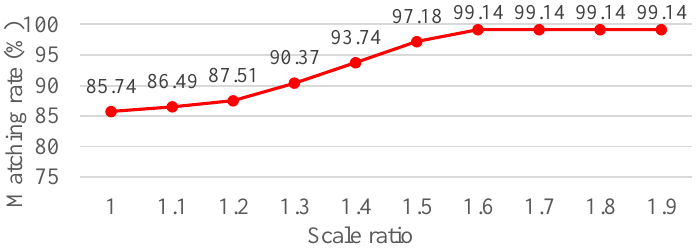
3 of 23 Figure 1. A flow chart indicates the template image and testing image are both utilized the proposed FBRLF method to compare the similarity. The procedure of the proposed FBRLF method is shown as the red box. 2.1. Scale-Space Feature Detection The accelerated segment test (FAST) [29] is a famous corner feature point detection, and the adaptive and generic corner detection based on the accelerated segment test (AGAST) [30] can significantly improve the FAST algorithm on its performance. Yet, feature points acquired through the FAST and AGAST are not scale-invariant. Consequently, this study proposes the multiscale AGAST (MAGAST) detector, which adopts a two-octave image-capturing technique to maintain scale-space invariance and proposes adaptive optimum threshold value based on AGAST which underlies the FAST. Specifically, this technique involves sampling an image twice, and prevents extensive calculation. Thus, it can achieve multiscale invariance, and increase the overall system efficiency. First, a set of captured images is processed for each octave. The first-octave and second- octave image sets are denoted as {𝐿 0 , 𝐿 1 , 𝐿 2 , … 𝐿 𝑛−1 } and {𝑀 0 , 𝑀 1 , 𝑀 2 , … 𝑀 𝑛−2 } , respectively. The process for building a two-octave image pyramid is described as follows. (1) If 𝐿 0 is the original image undergone smoothing once, then 𝐿 1 is generated by decimating 𝐿 0 by 1/2, 𝐿 2 is generated by decimating 𝐿 1 by 1/2, and so on. These images form the first-octave image set. (2) The second-octave image set is established on the basis of the first-octave image set. Specifically, M 0 is generated by decimating 𝐿 0 by 2/N, where N is the number of images per octave. M 1 is generated by decimating 𝑀 0 by 1/2, M 2 is generated by decimating 𝑀 1 by 1/2, and so on. In Eqs. (1) and (2), 𝑆(𝐿 𝑖 ) and 𝑆(𝑀 𝑖 ) represent the scale relationships of the first-octave image L i and second-octave image M i , respectively. 𝑆(𝐿 𝑖 ) = 2 𝑖 ,